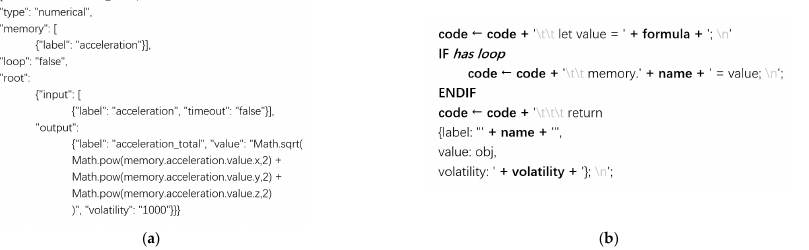
Figure 8. ( a ) The JSON configuration for the total acceleration magnitude calculator node that uses feedforward numerical processing. ( b ) The pseudocode of the server components that compiles the numerical-processing JSON file delivering JavaScript code.